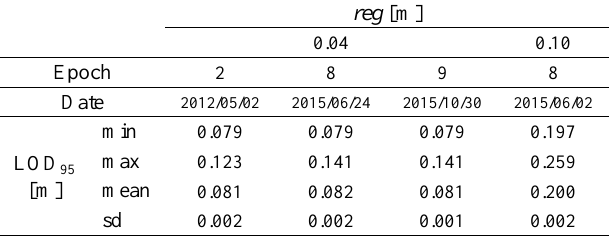
calculated with from different reg values, and hence LOD 95, vary systematically. The results obtained with larger registration error values (e.g. reg = 0.1 m) appear to represent